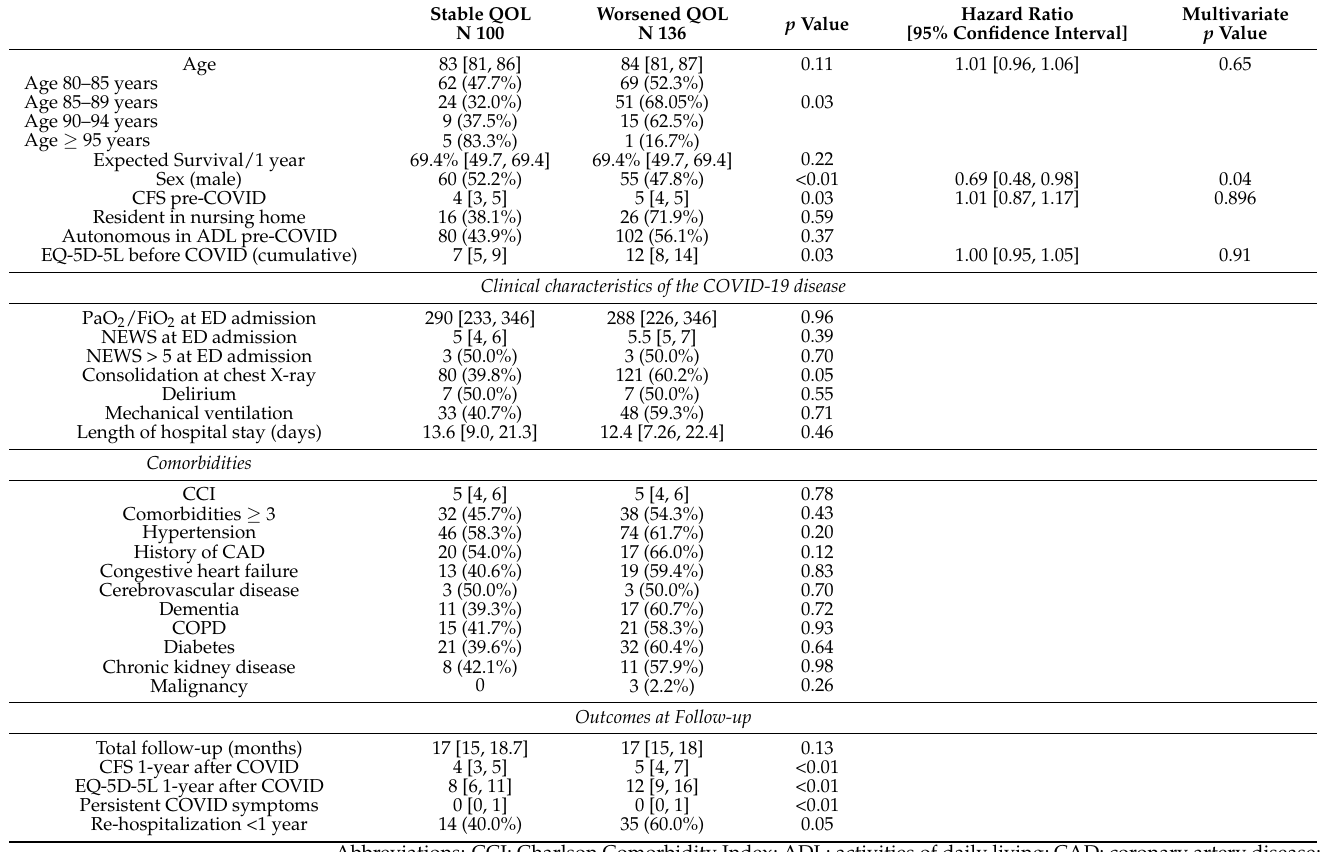
Table 3. Univariate and multivariate factors associated with the worsening of quality of life (QOL), as assessed by the EQ-5D-5L tool, in COVID-19 survivors at one-year follow-up. Pre-COVID clinical frailty scale (CFS) and 5-level EQ-5D cumulative values were forced into the multivariate Cox regression model. Expected survival at 1 year was calculated based on the data obtained from the Italian Registry of population in 2019. Time was calculated from index ED admission for COVID. Proportions are reported as row